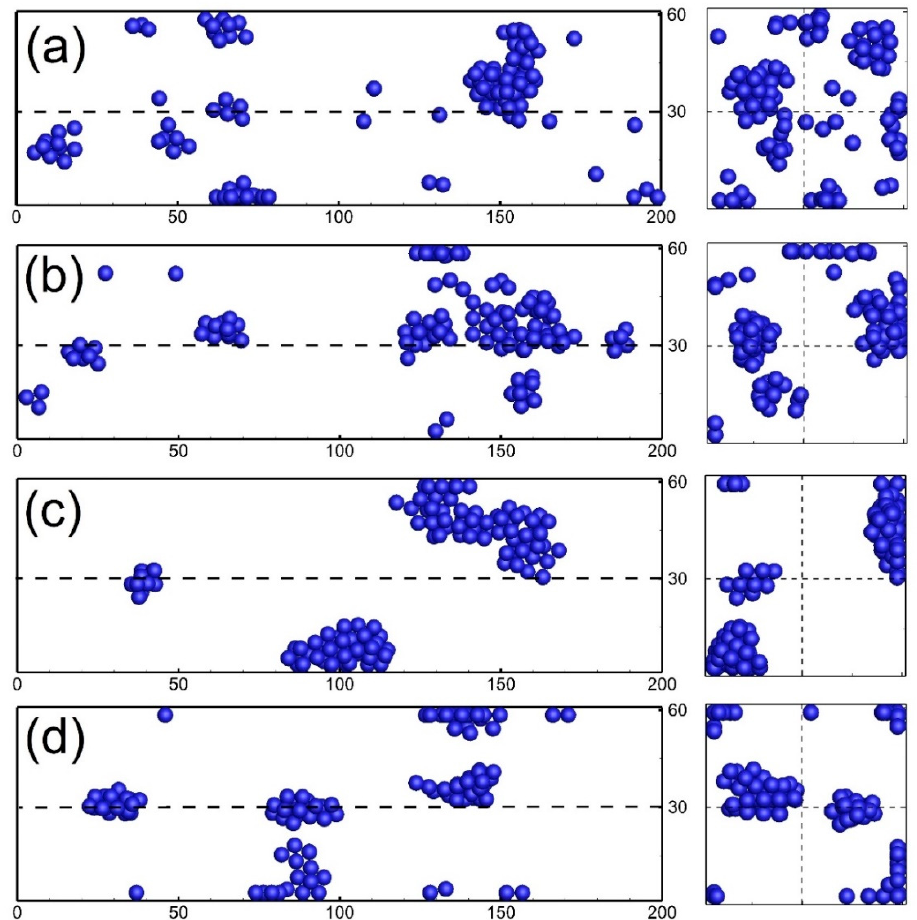
Figure 19. Snapshots of adhesive particle suspensions with γ = 0.075 and different Reynolds numbers ( a ) Re = 5.4, ( b ) Re = 21.6, ( c ) Re = 54 and ( d ) Re = 108. The left columns are side views and the right columns are cross-sectional view.